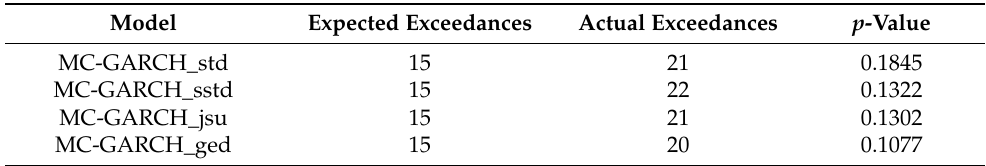
Table 9. Intraday ES forecast: Exceedance Residual (ER) backtest.